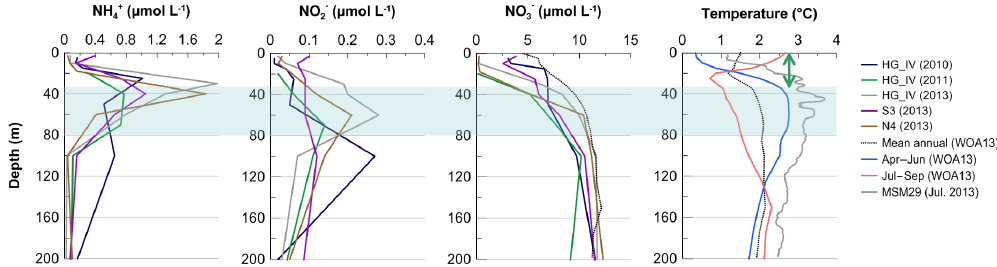
Figure 8. Depth profiles of nutrient concentration (NH + represent the central station of the Long-Term Ecological Research (LTER) observatory HAUSGARTEN (HG-IV), close to the FEVI16 trap location. The purple and brown lines represent the southern and northern stations of HG-IV. Black dotted lines for NO − blue and orange lines for temperature represent the datasets extracted from WOA13. Only two seasonal profiles (April to June and July to September) from WOA13 are available at the same location (79.125 ◦ N, 4.375 ◦ E) near the site FEVI16. Measured nutrient concentrations are reported on PANGAEA (Bauerfeind et al.,